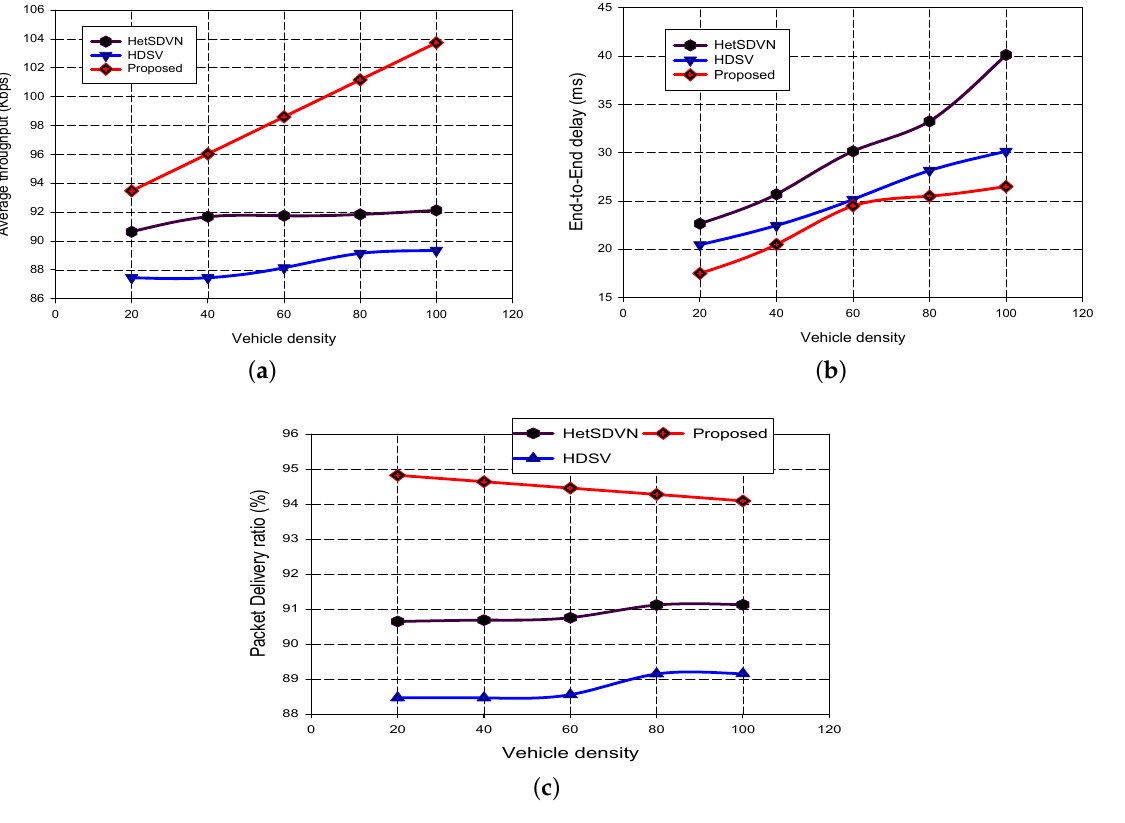
Figure 5. Evaluation performance of the proposed architectures with HSDV, HetSDVN versus vehicle density: ( a ) average throughput; ( b ) E2E delay; ( c ) packet delivery ratio